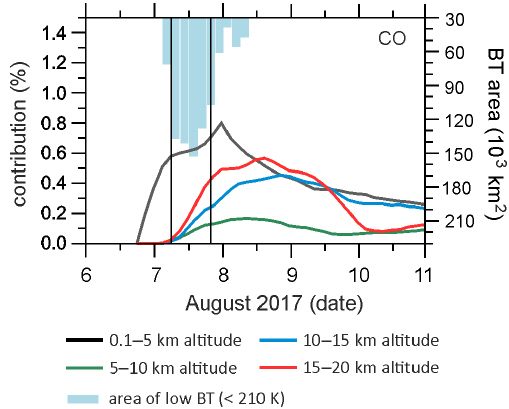
Figure 9. Temporal evolution of the contribution of Sichuan emis- sions to the CO concentration of the entire AMA region (60–120 ◦ E, 20–35 ◦ N) every 5km from 0.1 to 20km altitude from 6 to 9 Au- gust 2017. The areas of low brightness temperature (210K) in the Sichuan Basin (101–109 ◦ E, 26–33 ◦ N) are displayed by blue